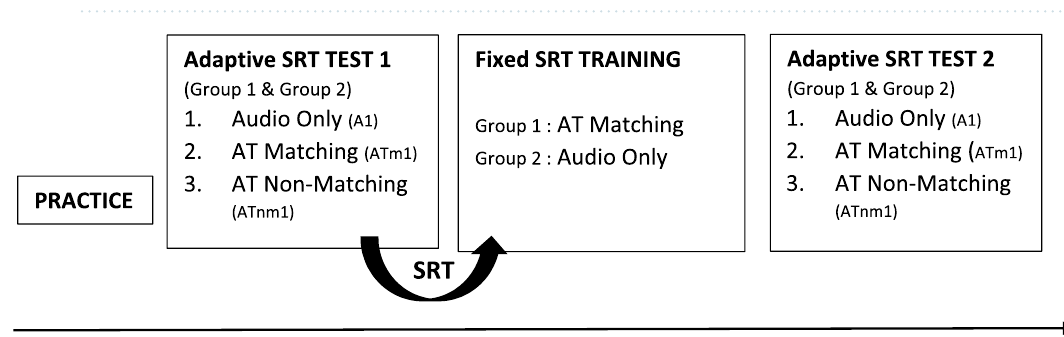
Figure 1. ( A ) The vibrating interface of the SSD and ( B ) the MatLab GUI.